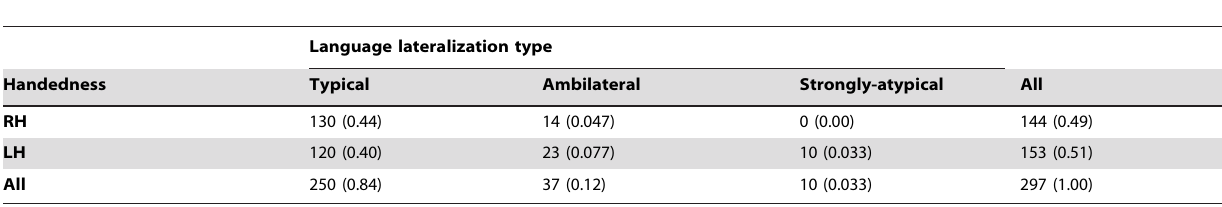
Table 7. Contingency table of language hemispheric lateralization type by self-reported handedness.